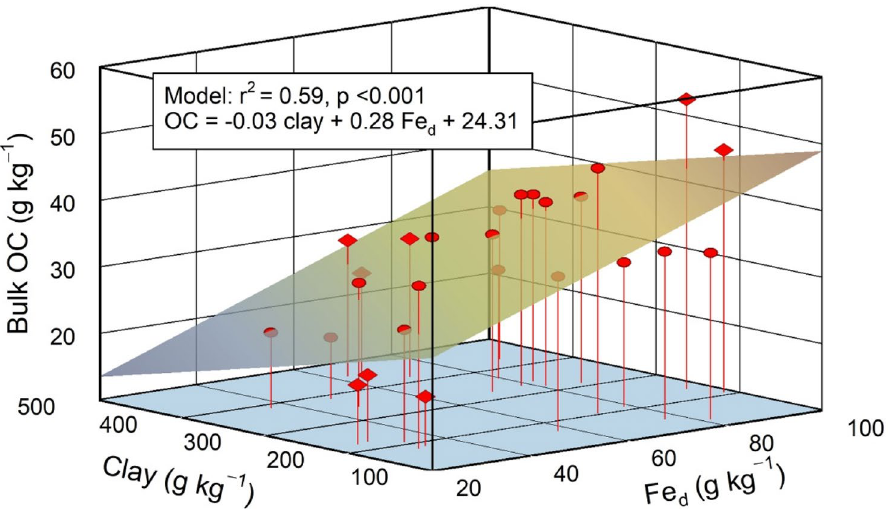
Figure 2. Multiple linear regression of bulk OC content in relation to aluminous clay (clay) and pedogenic Fe oxides (Fe d ) contents for all mineralogical combinations in 5 ‒ 10 cm soil depth ( n = 27). Circles and diamonds denote sites under forest and cropland, respectively. Aluminous clay represents the weight sum of